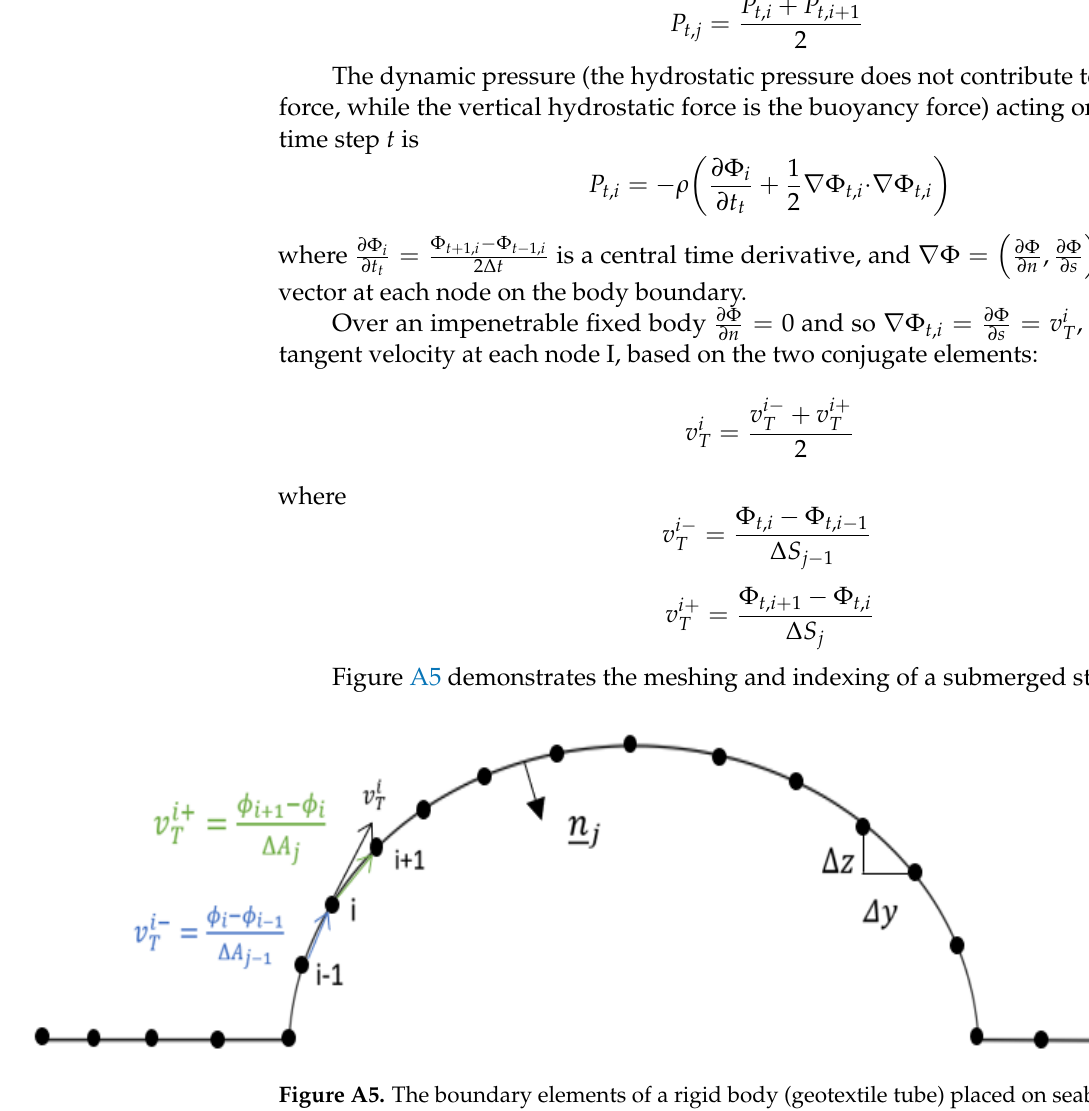
Figure A5. The boundary elements of a rigid body (geotextile tube) placed on seabed.